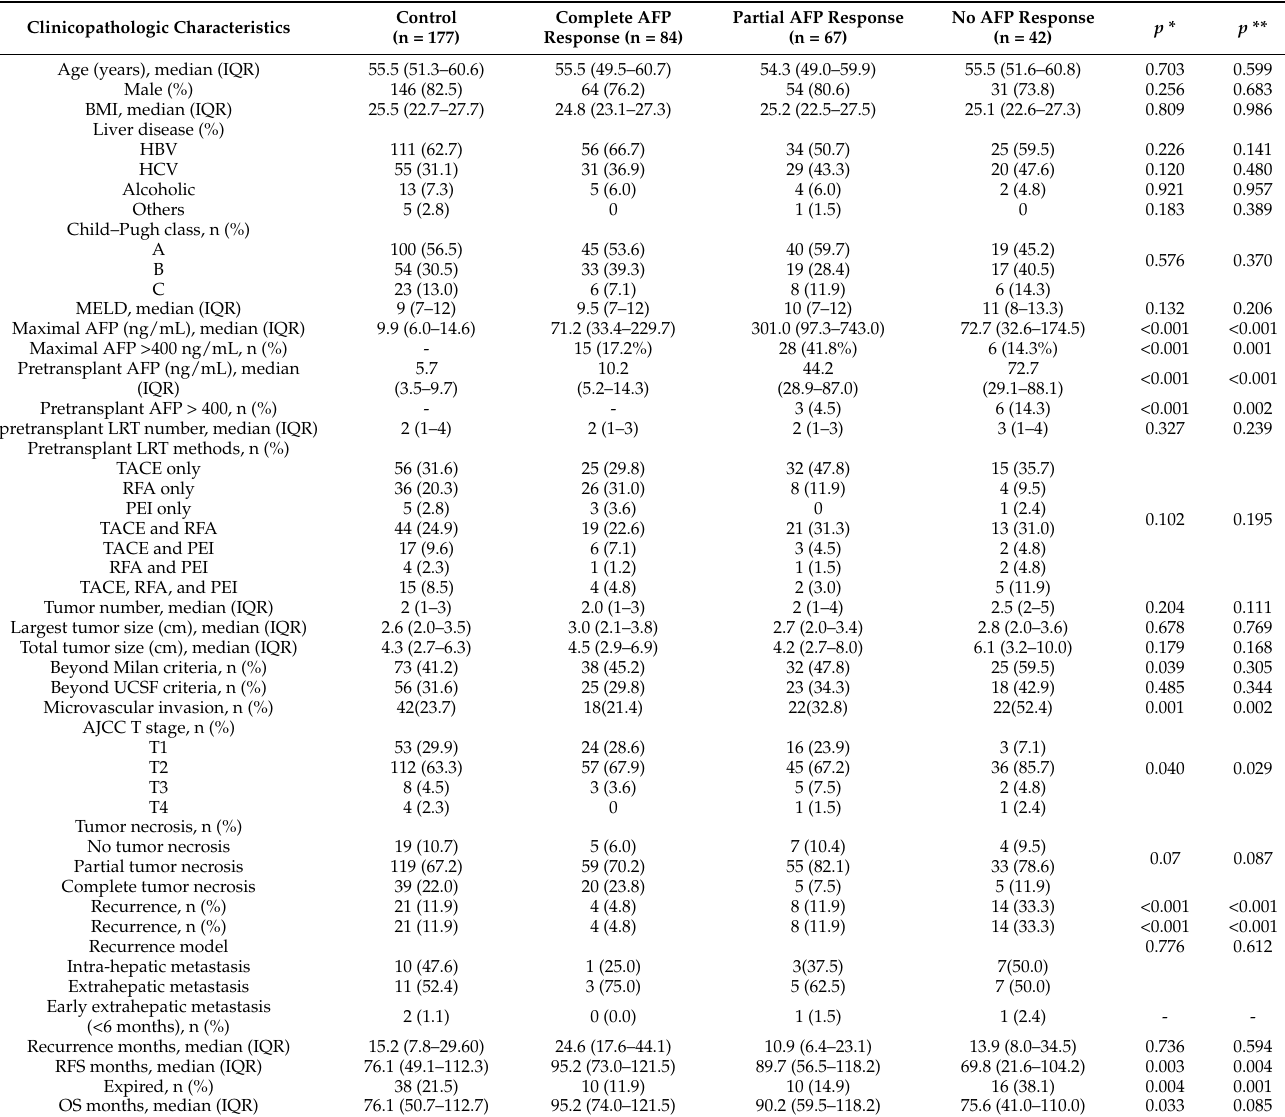
Table 2 shows the clinicopathologic characteristics of the four groups. The AFP-response groups had significant differences in microvascular invasion and American Joint Committee on Cancer (AJCC) T stage. The frequency of complete tumor necrosis was higher in the CR group; however, the AFP and pathologic response groups had only borderline significance. Regarding the correlation between the AFP-response groups and LRT, we found that the PR group had the highest percentage (41.8%) of pre-LRT-maximal AFP levels and the NR group had the lowest percentage (14.3%). The NR group also had the highest recurrence ( p < 0.001) and mortality rates ( p = 0.001) among the three groups. Consequently, the medium of recurrence months was significantly less than in the CR group ( p = 0.004) (Table 2). Table 2. Clinicopathologic characteristics of patients in the 4 groups according to locoregional therapy, pre-LRT AFP, and AFP